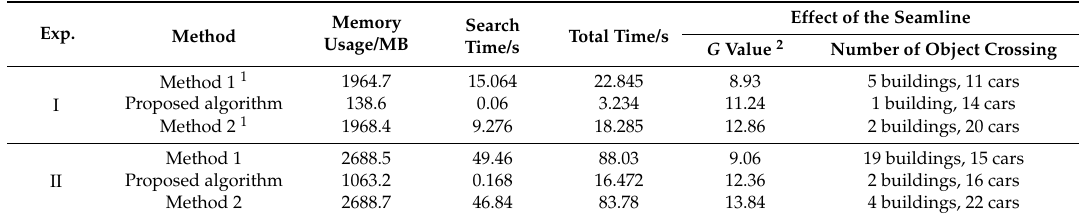
Table 2. Statistics of three methods for the seamline extraction in two experiments.